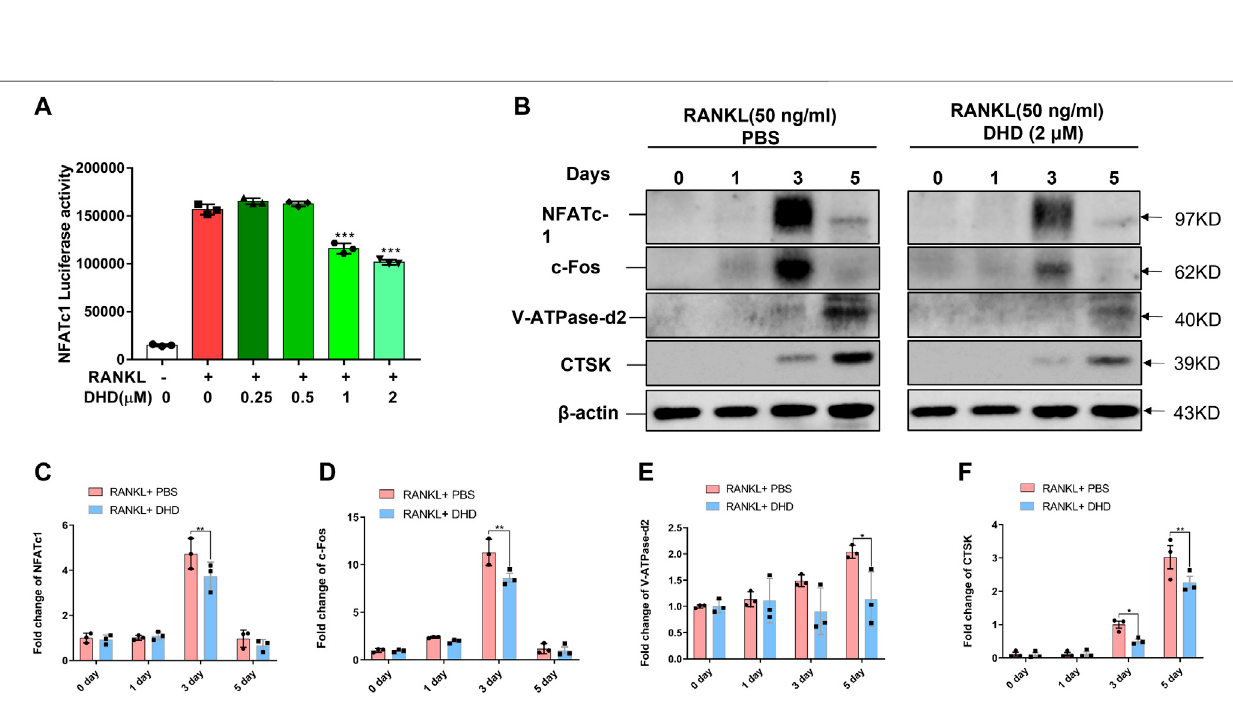
Frontiers in Pharmacology |